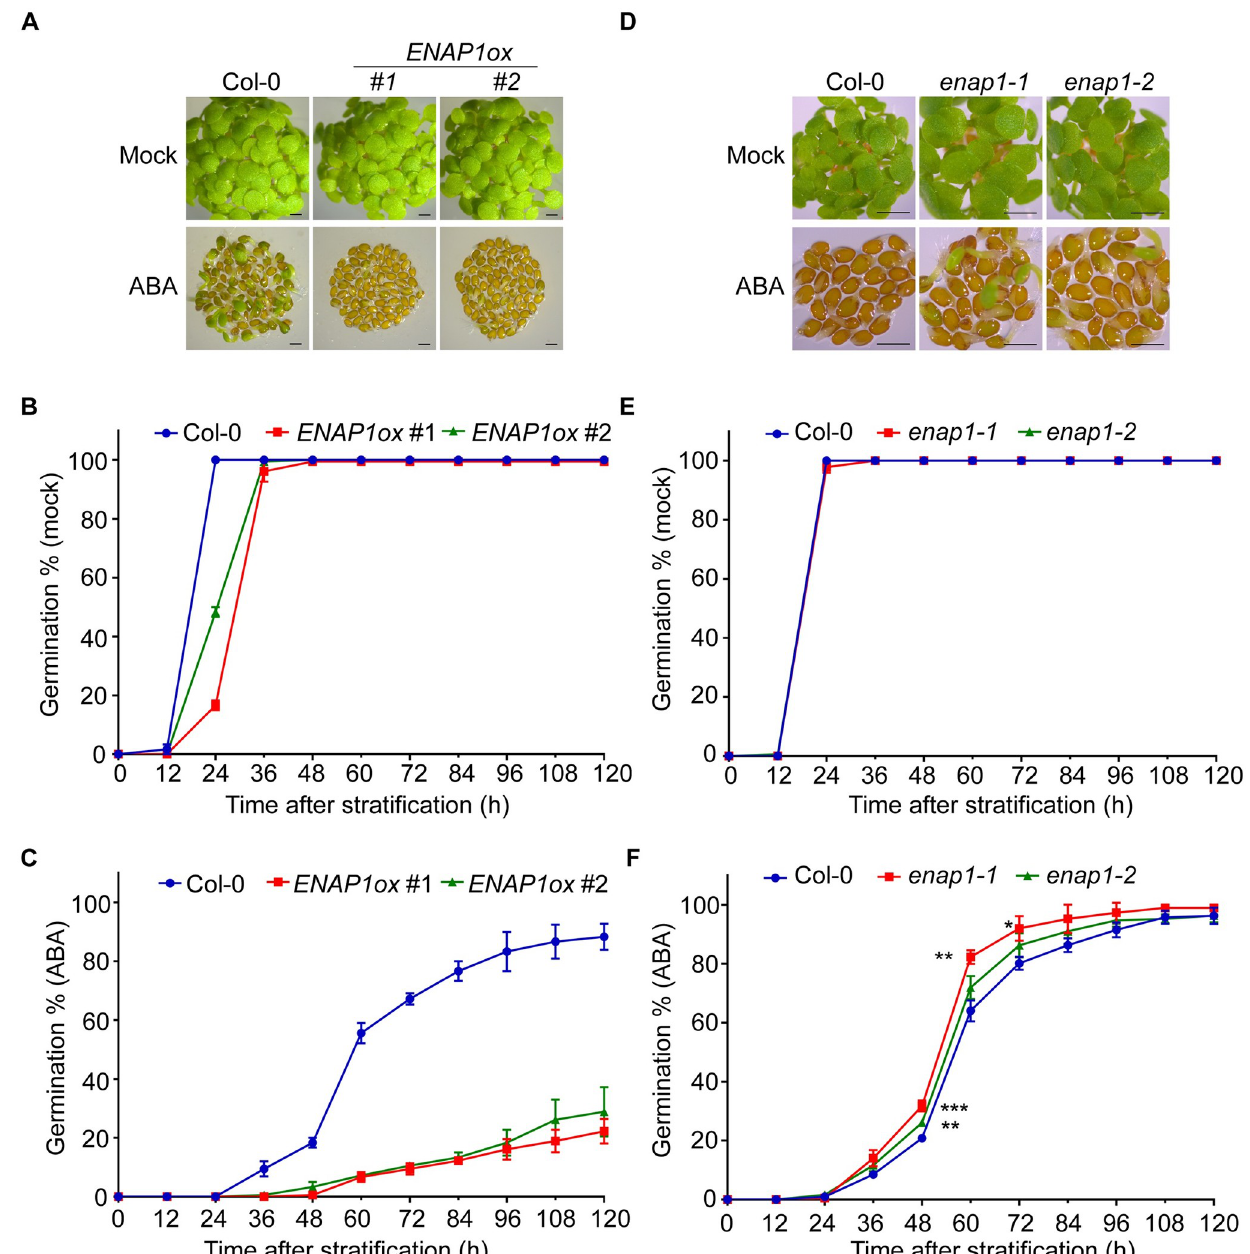
Fig 1. ENAP1 positively regulates ABA response to inhibit seed germination. ( A ) Germination phenotype of Col-0 and ENAP1ox independent lines. Stratified seeds of wild type (Col-0) and ENAP1ox (#1, #2) were germinated on ½ MS containing ethanol (mock) or 2 μ M ABA. Photographs were taken at 96h after stratification. Bar, 0.1mm. ( B and C ) Quantification of seeds germination rates in Col-0 and ENAP1ox lines. Seeds were germinated on ½ MS with mock ( B ) and 2 μ M ABA ( C ) treatment. Germinated seeds (radicle emerged) were recorded every 12h until 120h after stratification. ( D ) Germination phenotype of Col-0 and enap1 CRISPR/Cas9 deletion lines. Seeds germinated for 72h after stratification under mock (ethanol) or 2 μ M ABA treatment were imaged. Bar, 0.1mm. ( E and F ) Germination percentages of Col-0 and enap1 deletion lines. Stratified seeds of Col-0, enap1-1 and enap1-2 were germinated on ½ MS supplemented with ethanol ( E ) and 2 μ M ABA ( F ). Germinated seeds were counted every 12h until 120h after stratification. All quantified data represent means ± s.d. of at least 180 seeds in three replicates. Seed germination rates of enap1-1 and enap1-2 at 48h, 60h and 72h were compared to Col-0 with unpaired two-tailed t-test. � P < 0.05; �� P < 0.01; ��� P <